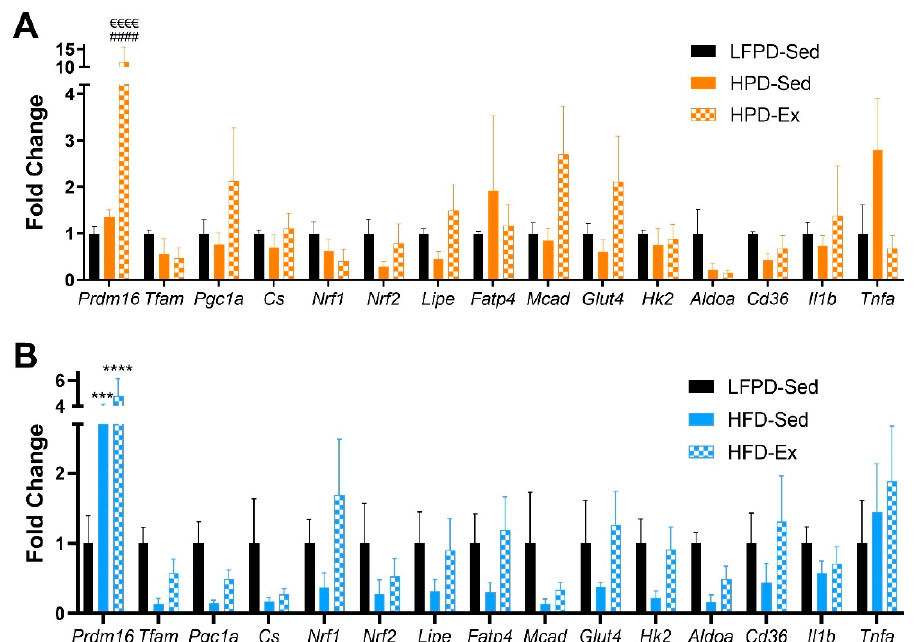
Figure 6. Exercise affects expression of metabolic and inflammatory genes in scWAT. ( A , B ) Gene expression data of scWAT (n = 3–7 per group). One-way ANOVA was used with Tukey’s multiple comparison test. (*** p < 0.001, **** p < 0.0001 LFPD vs. HFD, HPD vs. HFD, #### p < 0.0001 LFPD vs. HPD, €€€€ p < 0.0001 Sedentary vs. Exercise). Data are expressed as the mean ± SEM.